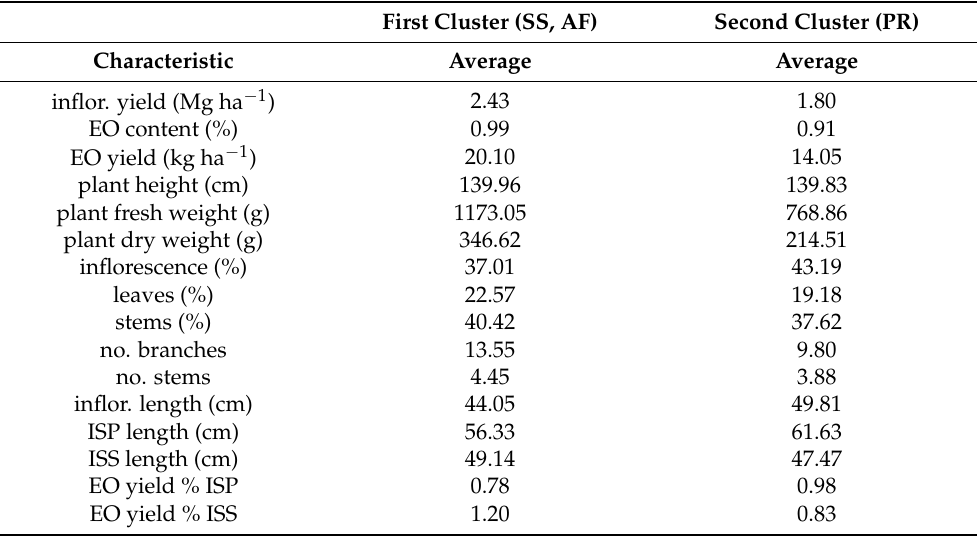
Table 4. Average values regarding morphological and production characteristics of the populations in each cluster.